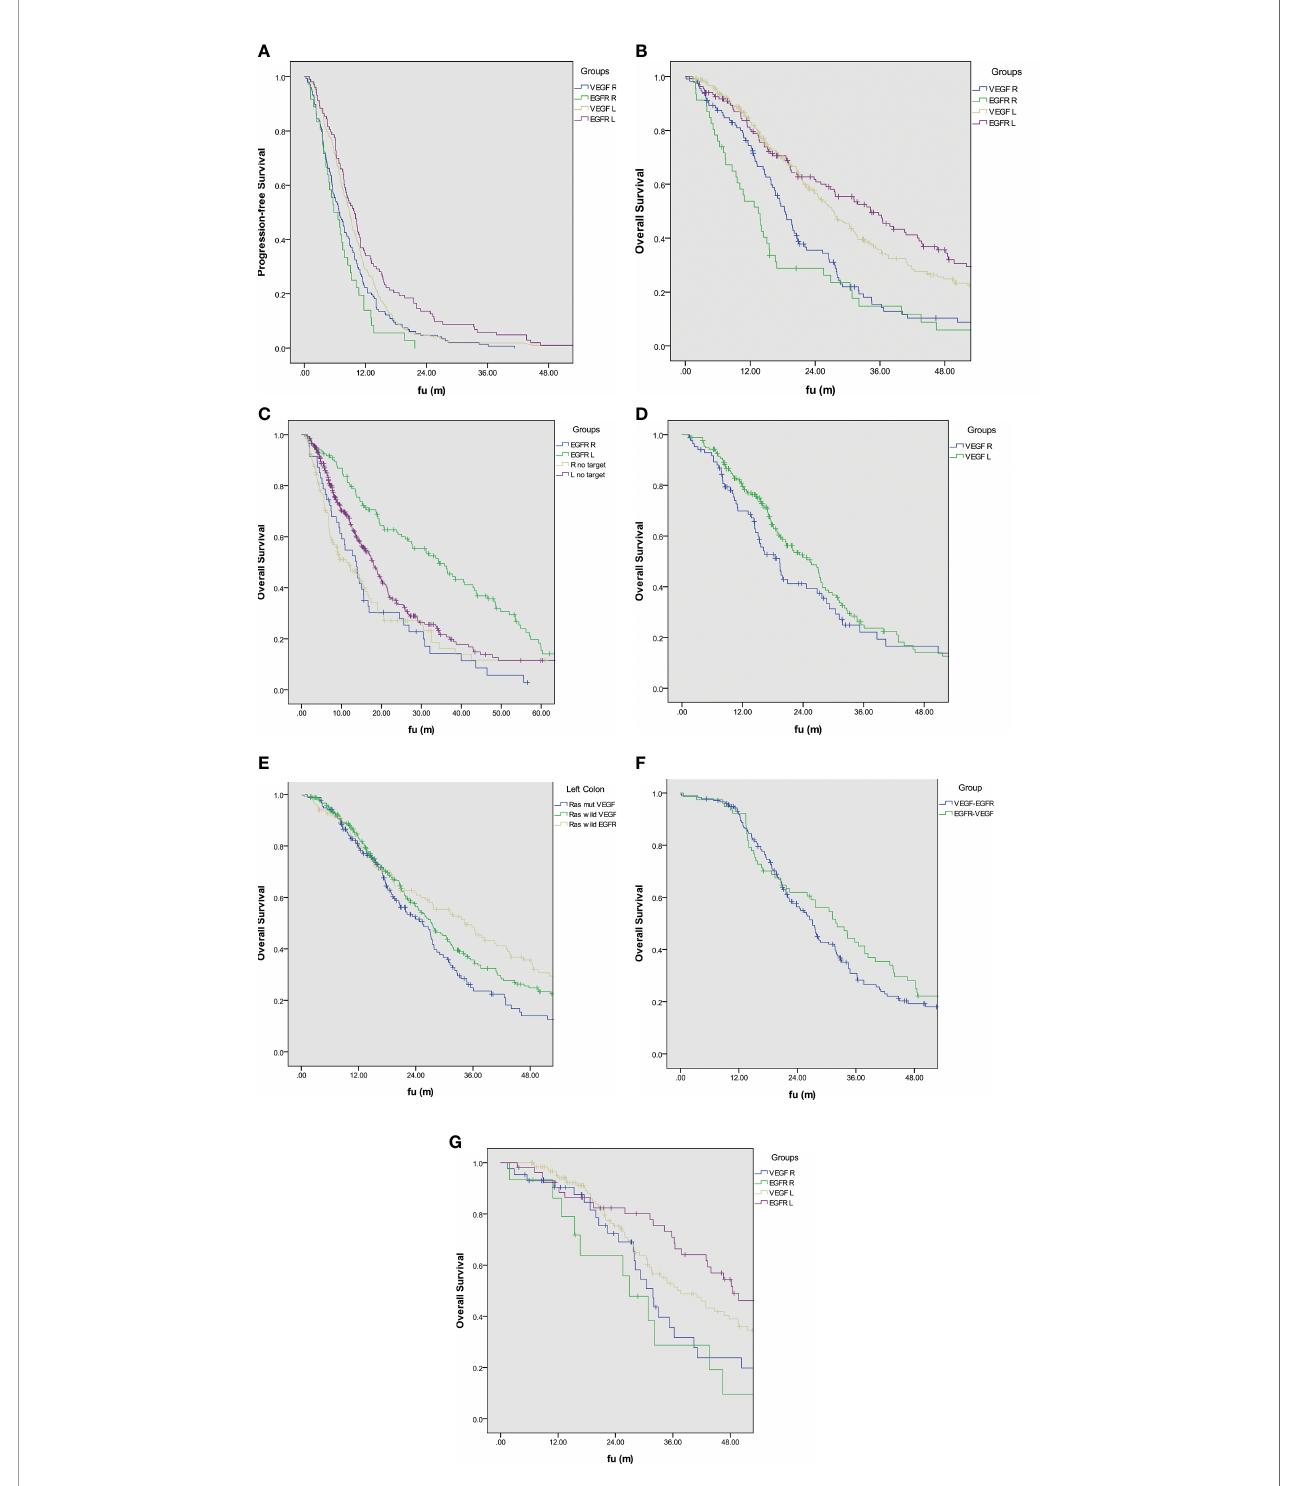
FIGURE 1 | (A) Kaplan – Meier estimates of progression-free survival based on target therapy and sidedness in Ras wild type mCRC. (B) Kaplan – Meier estimates of overall survival based on target therapy and sidedness in Ras wild type mCRC. (C) Kaplan – Meier estimates of overall survival with anti-EGFR therapy based on sidedness in Ras wild type mCRC. (D) Kaplan – Meier estimates of overall survival with anti-VEGF therapy based on sidedness in Ras mutation mCRC. (E) Kaplan – Meier estimates of overall survival based on target therapy and Ras mutation status in left-sided mCRC (F) Kaplan – Meier estimates of overall survival based on the sequence of target therapy. (G) Kaplan – Meier estimates of overall survival based on neoadjuvant target therapy and sidedness before